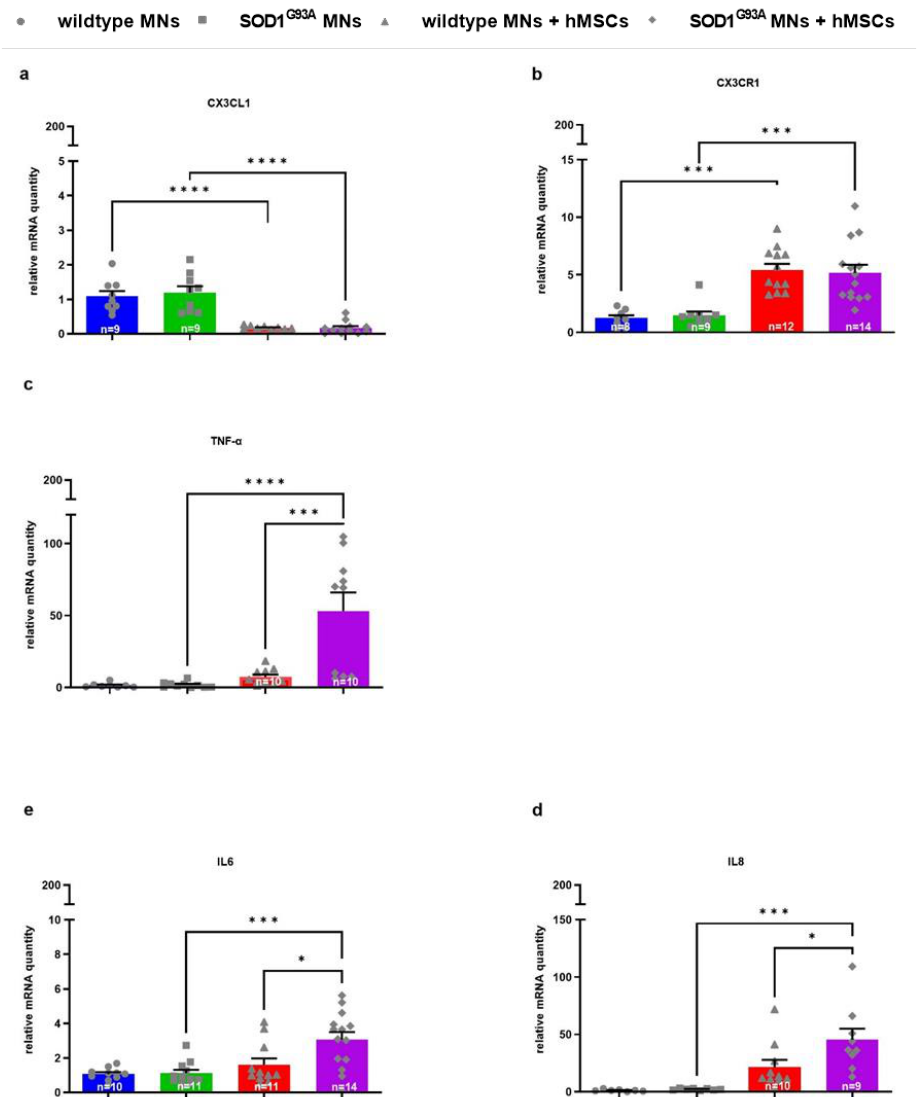
Figure 8. Altered mRNA levels of cytokines/chemokines (CX3CL1, CX3CR1, TNF- α , IL6 and IL8) in MNs co-cultured with hMSCs. 10,000 wildtype or SOD1 G93A motor neurons were seeded on 10,000 hMSCs. After 5 DIV cells were lysed and mRNA was isolated and transcribed to cDNA. Quantitative analysis was performed with HPRT1 (for CX3CL1, IL6, IL8, respectively), PPIA (for CX3CR1) and GAPDH (for TNF α ) as housekeeping genes and expression patterns were analysed by comparative Ct method (2 − ∆∆ Ct ). ( a ) CX3CL1 mRNA levels ( n = 9–12). ( b ) CX3CR1 mRNA levels ( n = 8–14). ( c ) TNF α mRNA levels ( n = 8–10). ( d ) IL8 mRNA levels ( n = 7–9). ( e ) IL6 mRNA levels ( n = 10–14). Statistical analyses were performed with ordinary one-way ANOVA and Tukey’s multiple comparisons post-hoc test: * p < 0.05, *** p < 0.01 and **** p < 0.0001. Single values are represented as repeated measurements together with mean ± SEM. Statistic analysis between monocultures and co-cultures of different genotypes are not